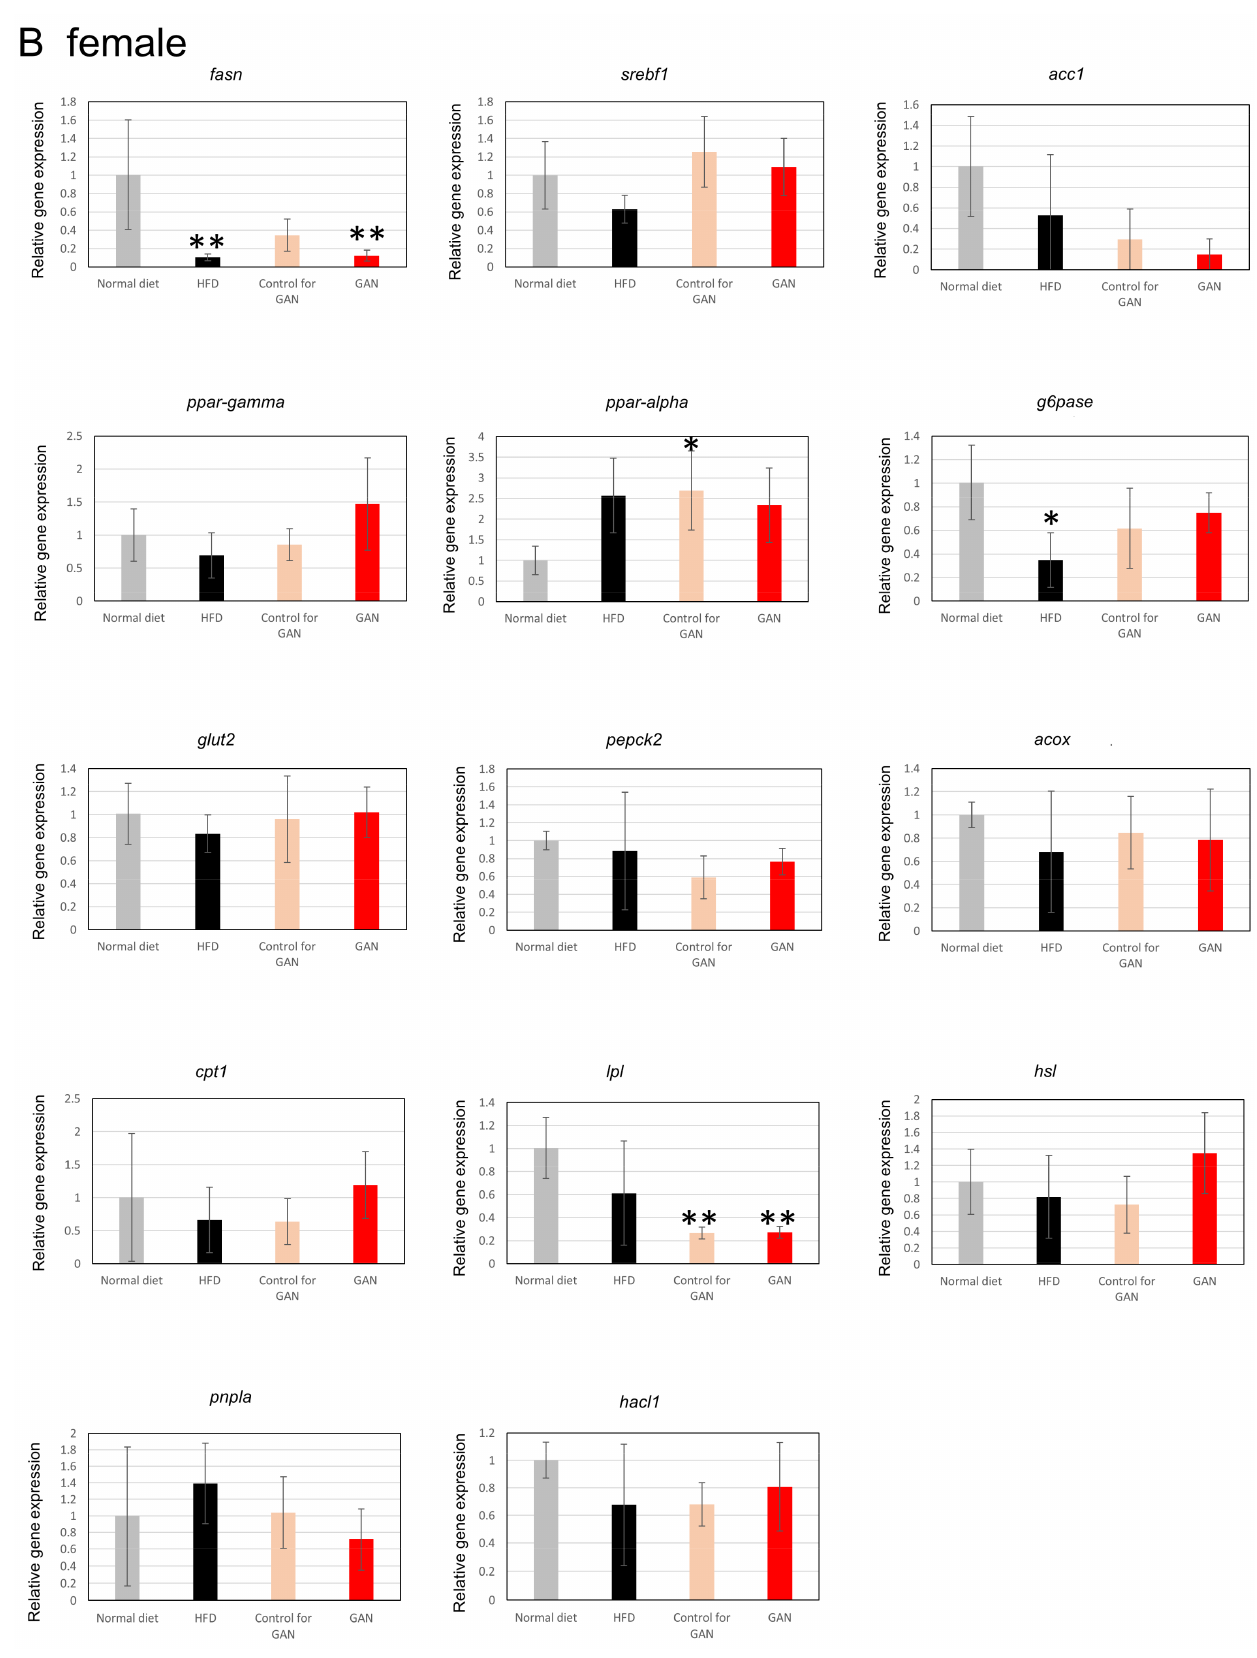
Figure 2. Expressional analysis of medaka genes by real-time RT PCR. ( A ): male; ( B ): female. Data are represented as the mean ± standard deviation (SD), ( n = 4); * indicates significant difference ( p < 0.05), ** indicates significant difference ( p <